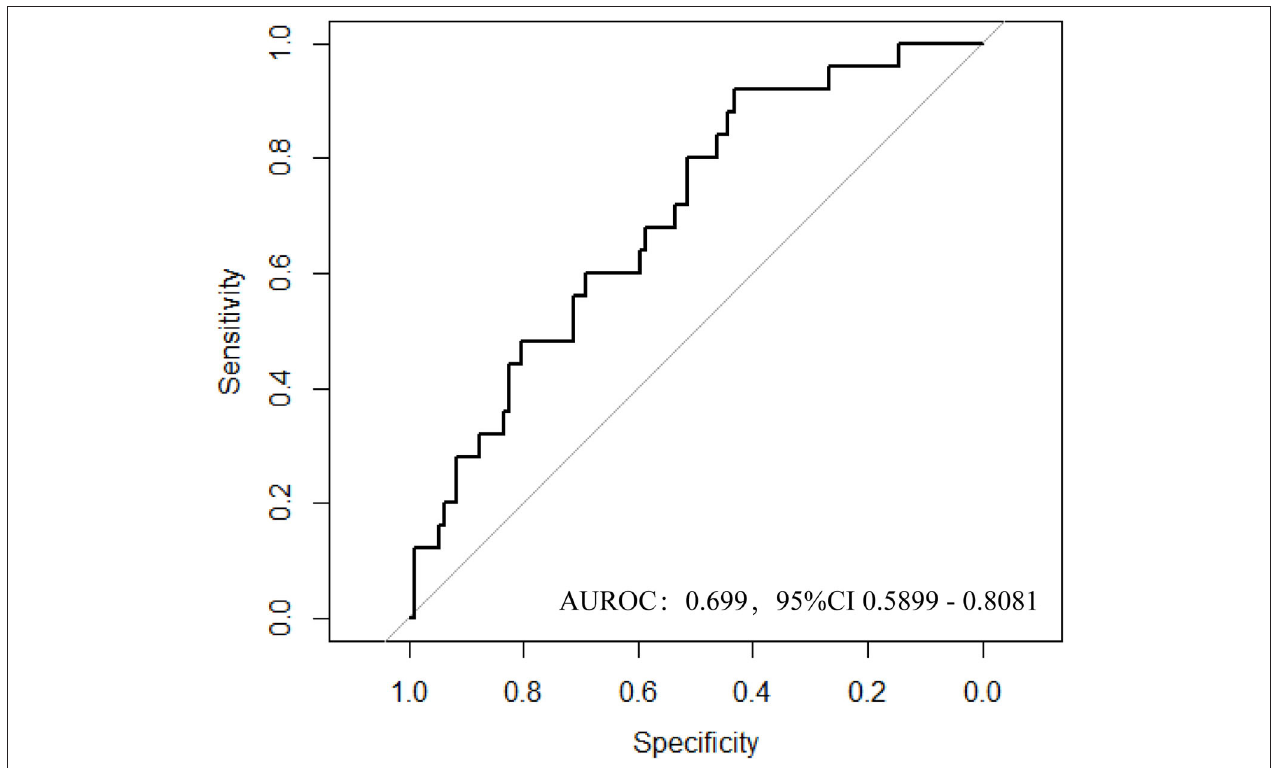
FIGURE 4 | Discriminatory performance in external datasets for adverse BKV infection